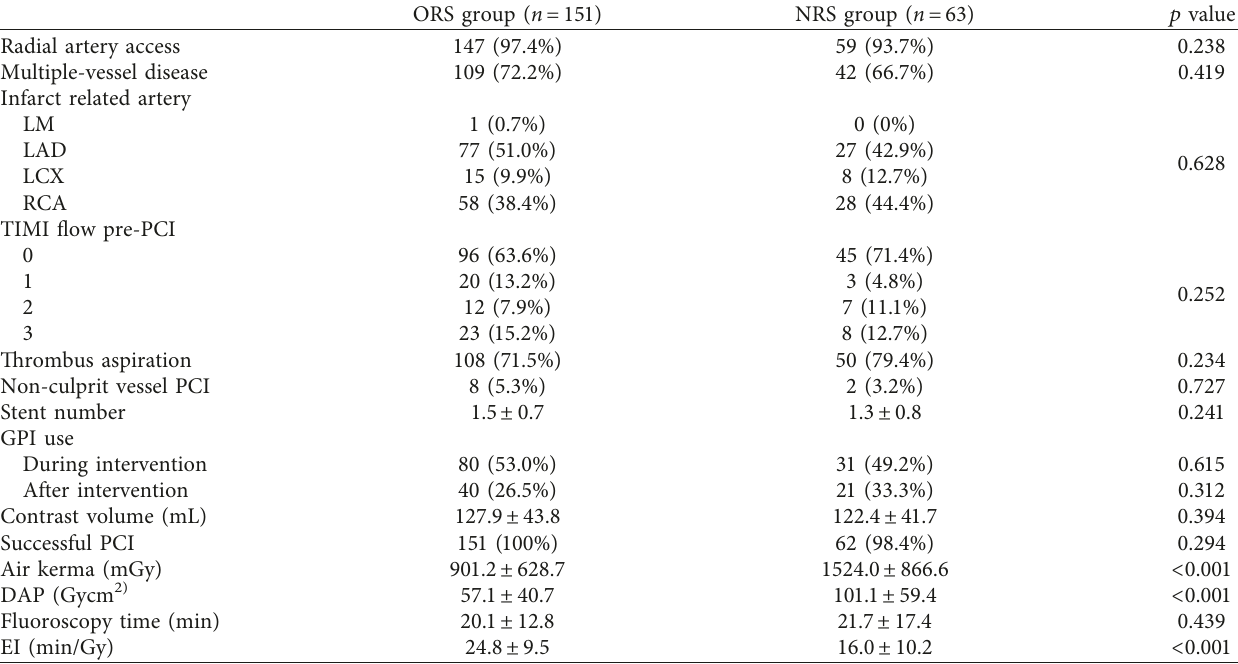
Table 2: Procedural and radiation dose